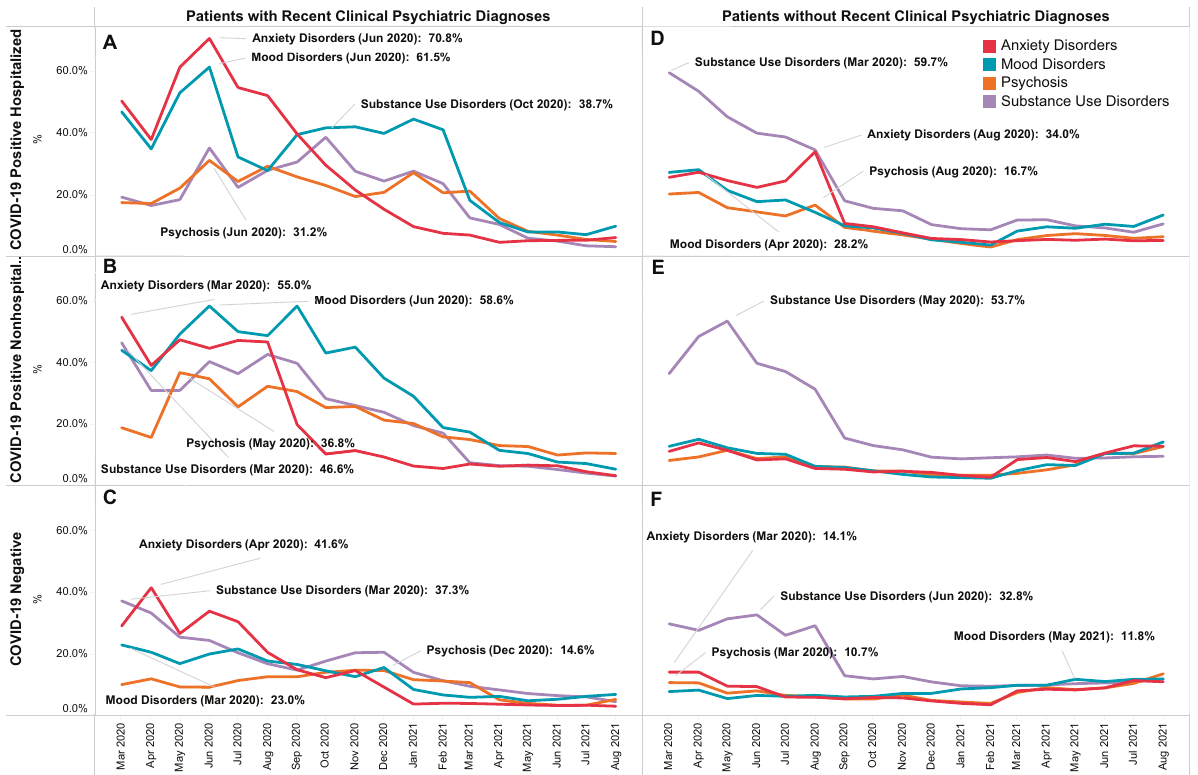
Fig. 4 Trends of clinical psychiatric diagnoses by COVID-19 infection and hospitalization status, separated by recent clinical psychiatric diagnoses. A Trends in patients with recent psychiatric diagnoses and COVID-19 positive with hospitalization. B Trends in patients with recent psychiatric diagnoses and COVID-19 positive nonhospitalized. C Trends in patients with recent psychiatric diagnoses and COVID-19 negative. D Trends in patients without recent psychiatric diagnoses and COVID-19 positive with hospitalization. E Trends in patients without recent psychiatric diagnoses and COVID-19 positive nonhospitalized. F Trends in patients without recent psychiatric diagnoses and COVID-19 old, female, Black, and Hispanic patients who tested positive for conditions (e.g., cancer, cerebrovascular diseases, congestive heart COVID-19, but who experienced barriers to accessing healthcare failure, pulmonary disease) [40]. After being infected by SARS-CoV- facilities for psychiatric treatment and diagnoses during the peak 2, patients with pre-COVID clinical psychiatric diagnoses, com- of COVID-19 infection in NYC [47, 48]. pared with those without, may have greater risks for subsequent Similar to a cross-sectional study in Italy [49], we observed psychiatric disorder diagnoses because of greater levels of stress, increases in psychiatric diagnoses were the highest early in the dysregulated immune functions [41], and social and economic consequences [3, 35]. In early March 2020, NYC emerged as an epicenter for COVID-19 [42], which exerted sudden and widespread closures of medical practices, disrupting access to mental health services for patients with pre-existing clinical psychiatric diagnoses [43]. The unprece- dented social distancing policies also introduced stress, fear, and uncertainty that may have disproportionately impacted patients with pre-COVID clinical psychiatric diagnoses [35, 37, 44]. Differential trends by COVID-19 infections and severity Previous studies suggested that COVID-19 positive patients who survived are at increased risk of psychiatric sequelae [1]. We extended this line of research by demonstrating short-term and long-term (18 months) changes in psychiatric diagnoses across different stages of the pandemic [45]. For all patients, regardless of COVID-19 infection, anxiety and mood disorders diagnoses remained high in the fi rst six months of the pandemic, which may have re fl ected the secondary impacts of the COVID-19 pandemic on mental health (e.g., through lockdown, social distancing, economic disruptions, grief, and loss) [11, 46]. The monthly percentages of psychiatric diagnoses decreased during the fi rst month (March-April 2020) in COVID-19 positive patients, which may be explained by larger representations of 45 – 64 years